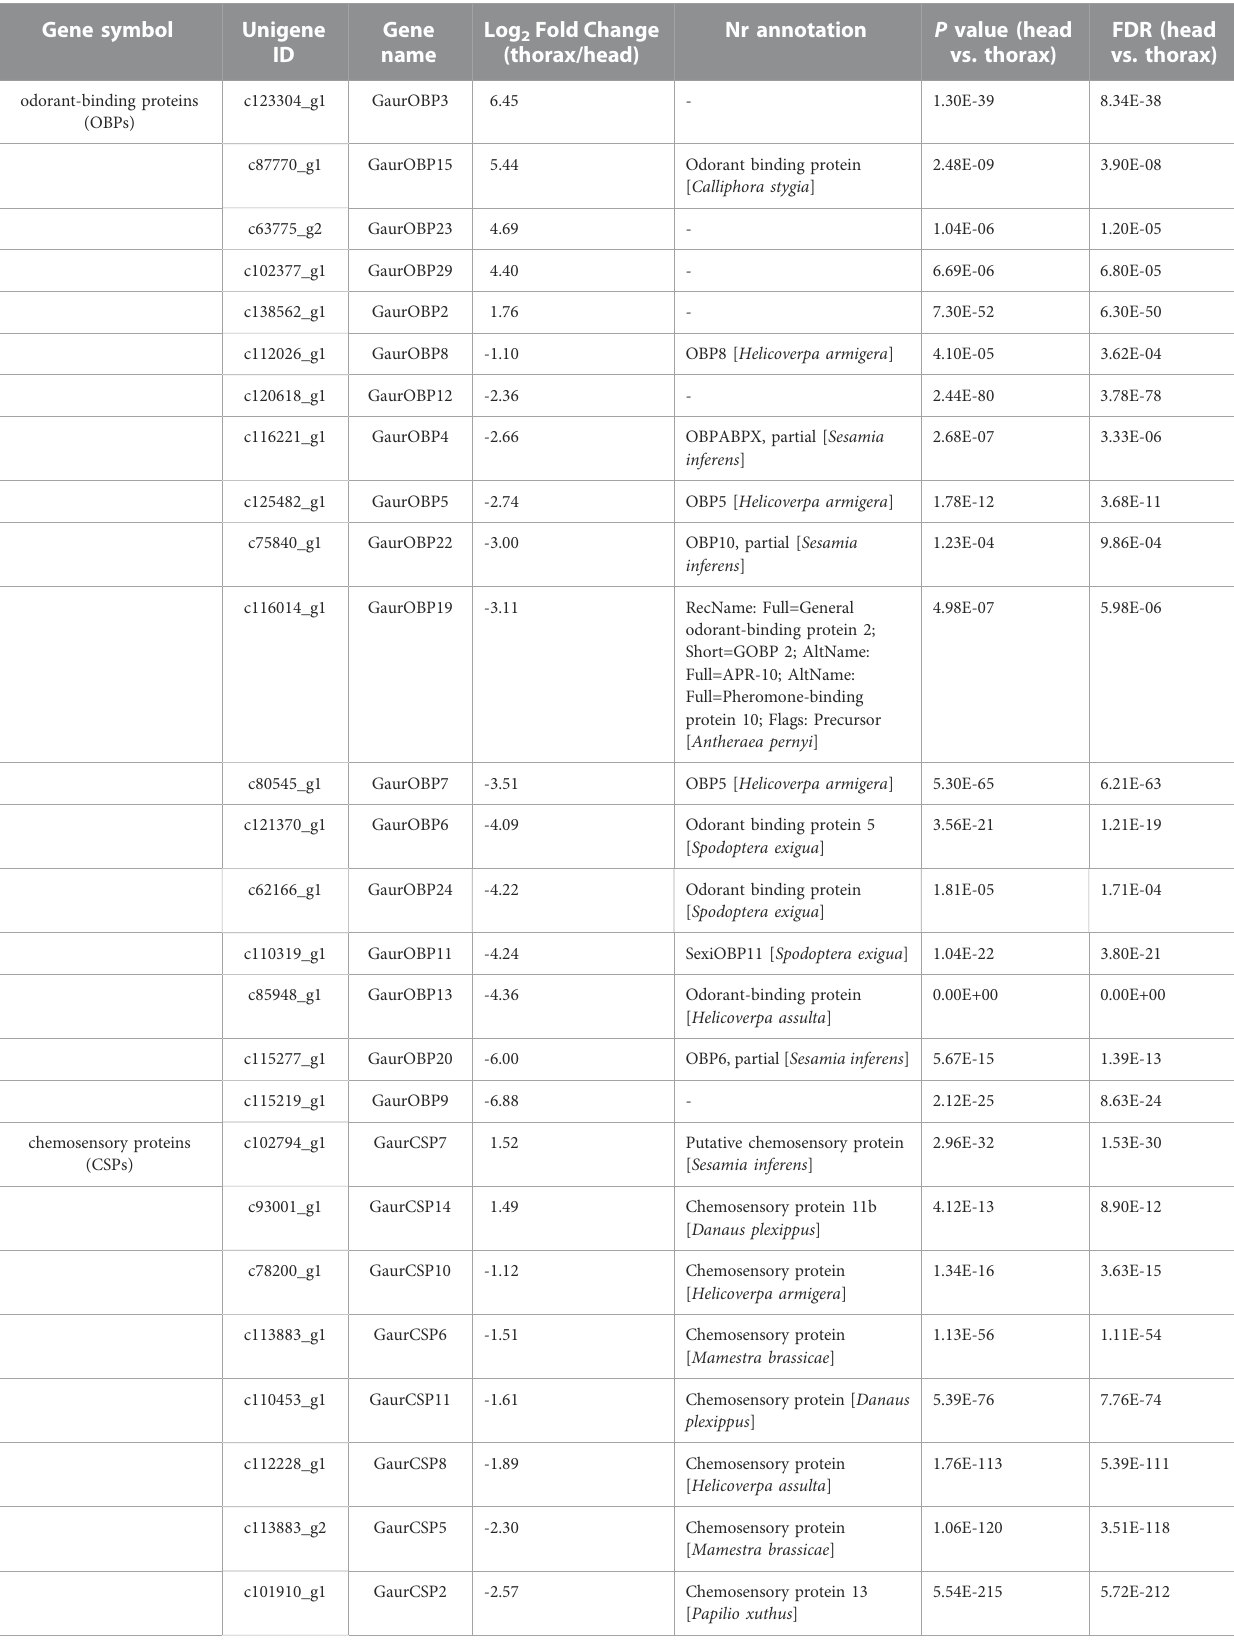
TABLE 1 Summary of all signi fi cantly differential expressed olfactory-related genes between the head and thorax transcriptomes of Gynaephora aureata . FDR represents the corrected p -value. Gene symbol Unigene